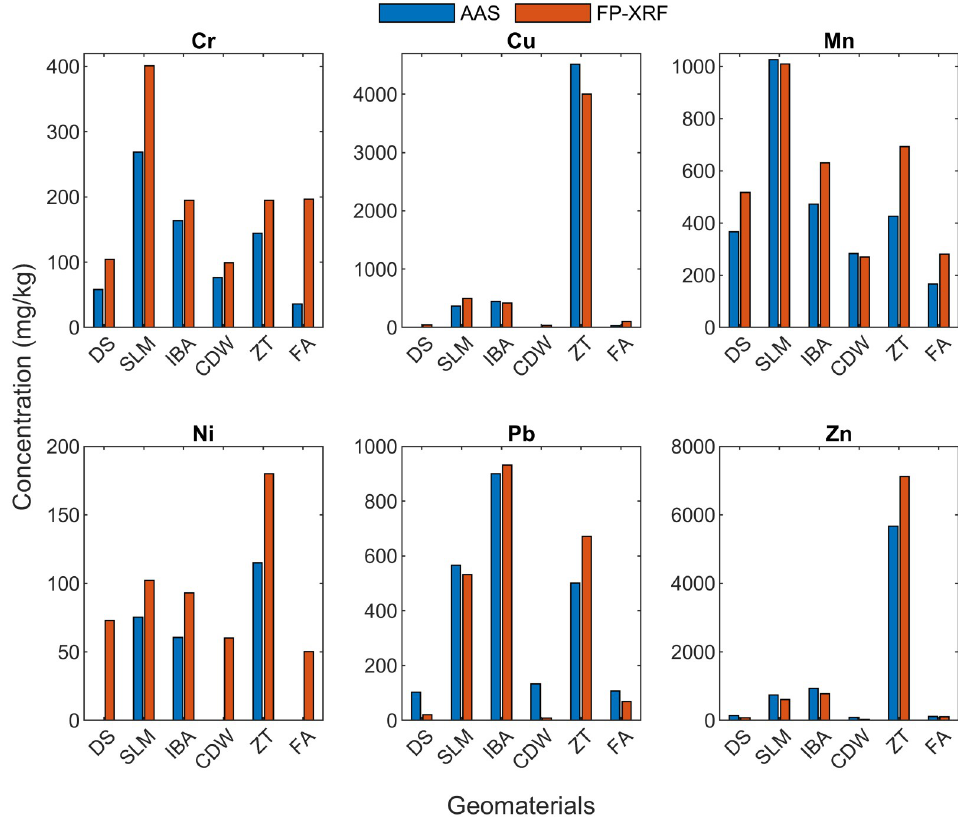
Fig 4. Comparison of elemental concentration of Delhi silt with geomaterials using FP-XRF and AAS.